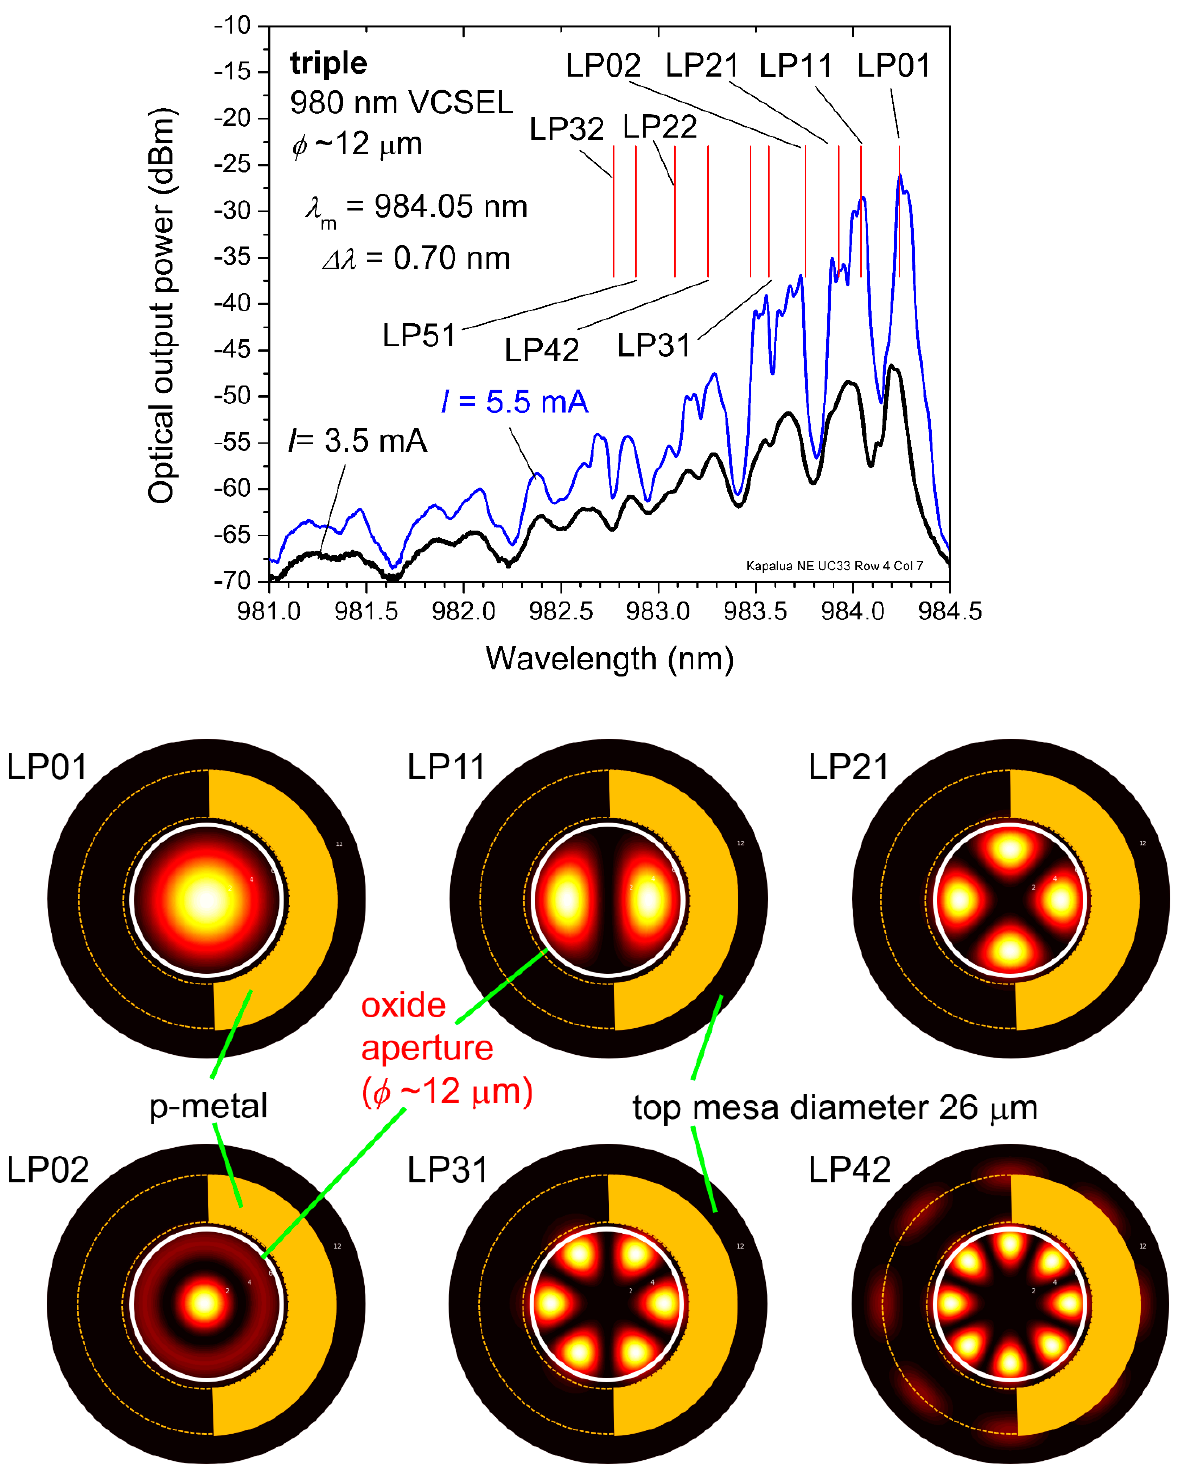
Figure 6. ( top ) Measured spectral emission for a 980 nm triple VCSEL array with φ ~12 µ m and top mesa diameters of 26 µ m, at static bias currents of I = 3.5 mA (below threshold) and I = 5.5 mA (above threshold). The vertical red lines indicate the wavelengths of some of the simulated LP modes. ( bottom ) Simulated (cold cavity) two-dimensional (2D) near field (surface) modes (normalized resonant optical field intensities) of any one VCSEL in the array. The array includes 3.5 µ m wide (and 3 µ m from the top mesa 1 edge) top surface p-metal contacts, partially removed here for ease of viewing (but included in the simulations). In the simulation, we adjusted the VCSEL etalon to fit the LP01 mode wavelength at I = 3.5 mA; all other wavelengths followed naturally.